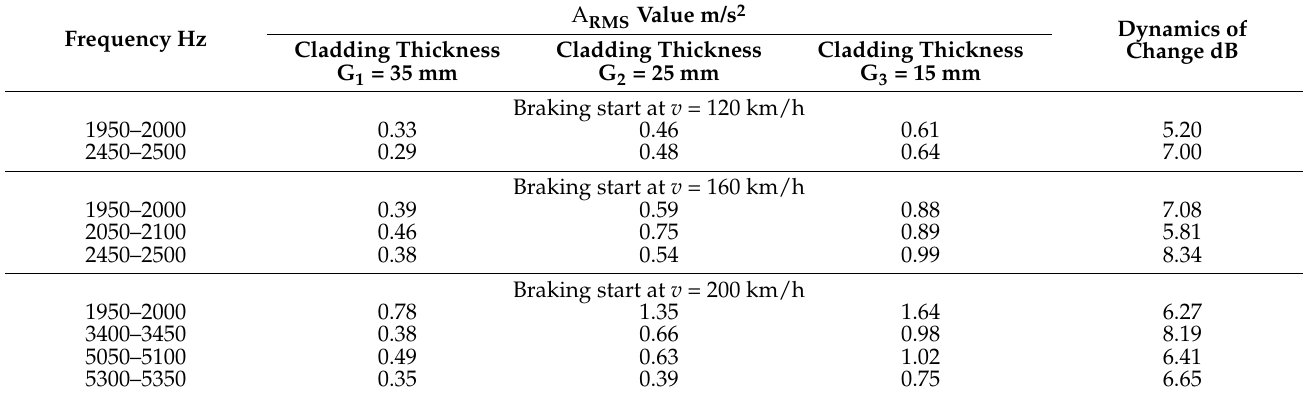
Dynamics of Change dBCladding Thickness